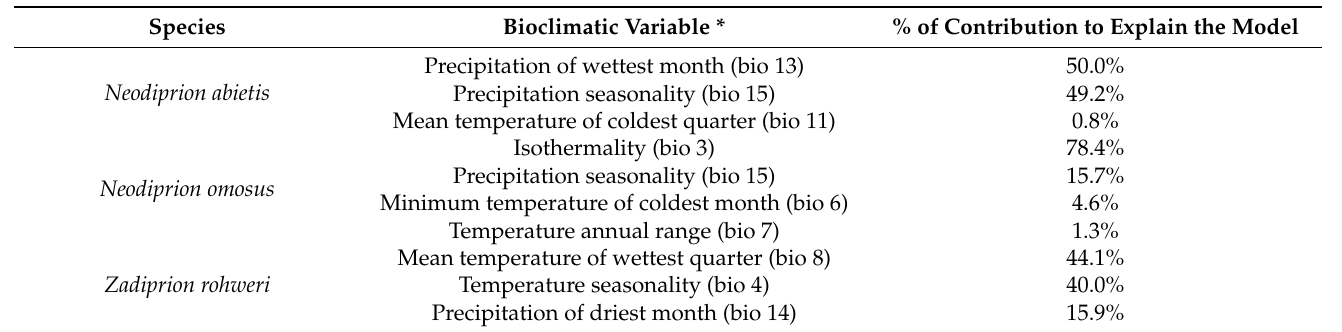
Table 3. Bioclimatic variables and their % contribution to explain the final ecological niche model of three species of sawflies (Hymenoptera: Diprionidae) in